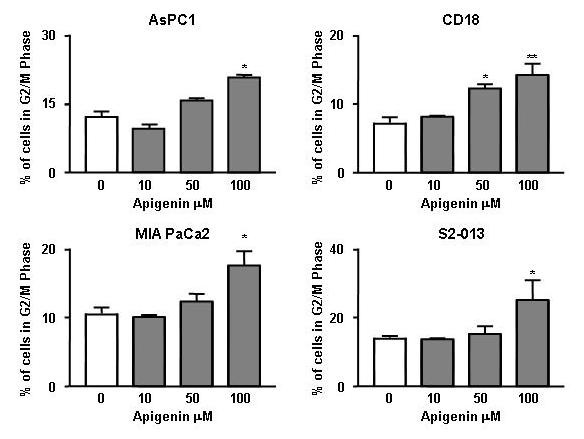
Concentration-dependent effects of apigenin on the cell cycle. Higher concentrations of apigenin cause a concomitant increase in the percentage of cells in the G2/M phase. AsPC-1 [F (3,8) = 12.79, P < 0.002 (P < 0.01 with 100 μM)]; CD18 [F (3,8) = 9.504, P < 0.0128 (P < 0.05 with 50 μM and P < 0.01 with 100 μM)]; MIA PaCa2 [F (3,10) = 6.062, P < 0.0128(P < 0.01 with 100 μM)]; S2-013 [F (3,10) = 4.071, P < 0.0394 (P < 0.05 with 100 μM)]. *= P < 0.05; **= P < 0.01 compared with control.